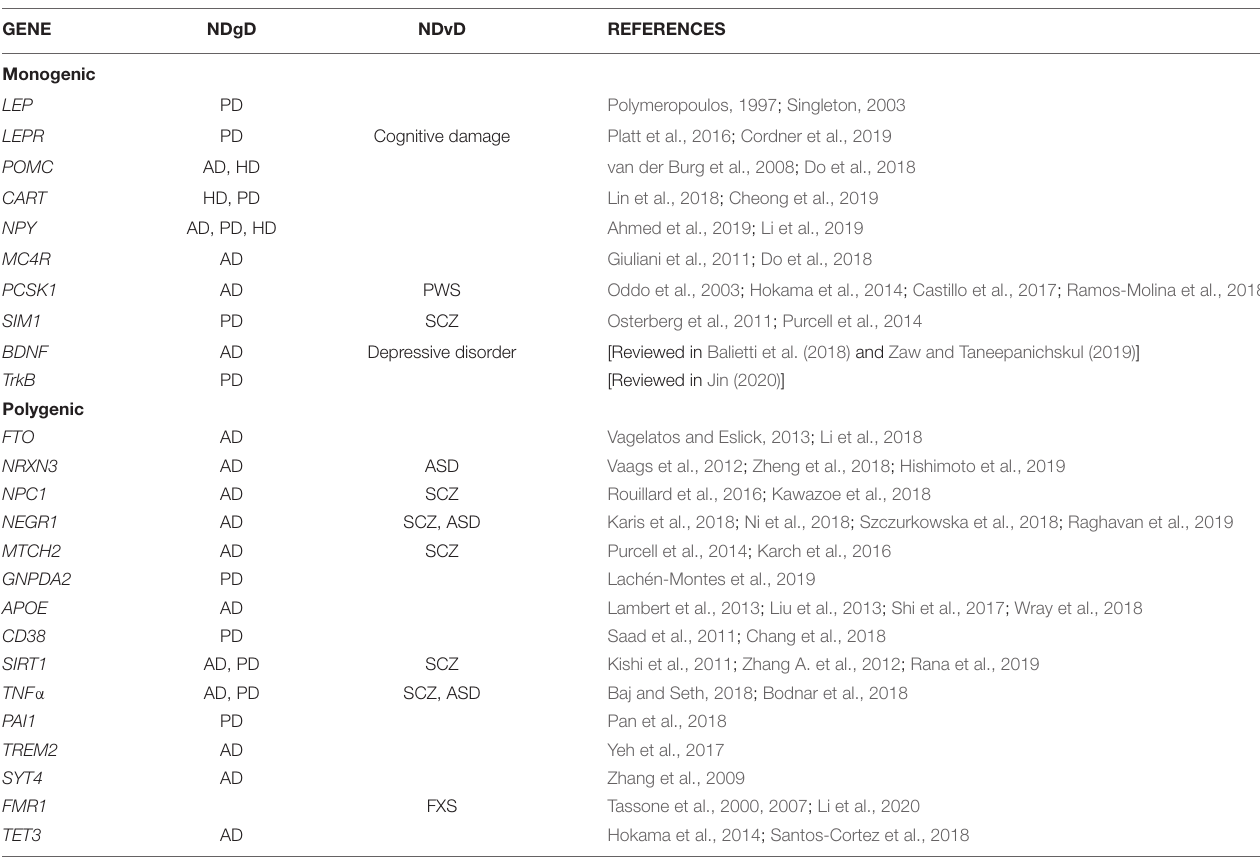
TABLE 1 | Genes associated with obesity and NDgD or